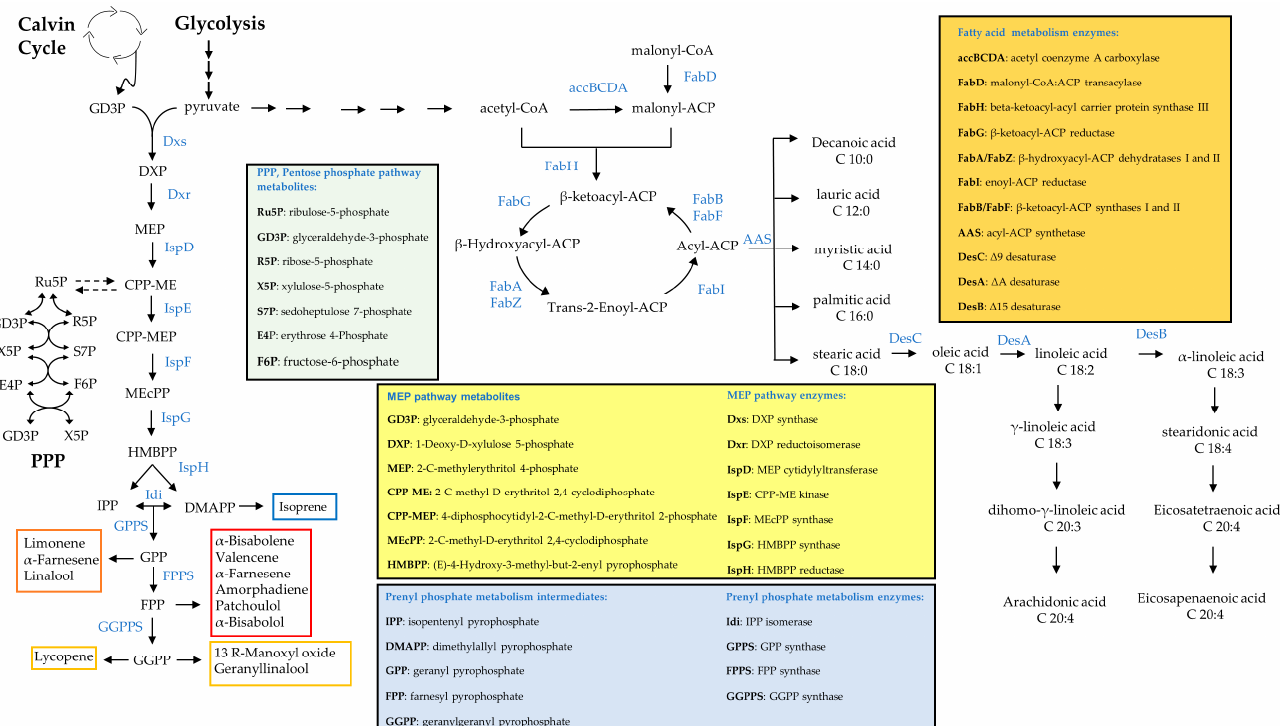
Figure 2. Schematic representation of biosynthetic routes for terpenoids and fatty